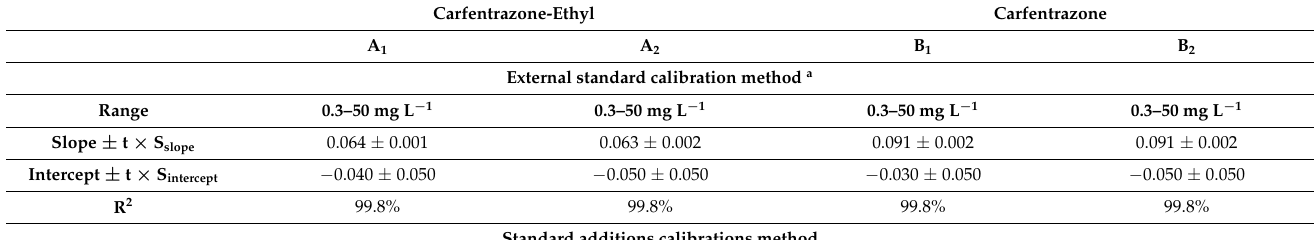
Figure 3. Electropherograms corresponding to the simultaneous separation of carfentrazone-ethyl and carfentrazone enantiomers from a standard solution containing 30 mg L −1 of carfentrazone-ethyl racemate and 20 mg L −1 of carfentrazone racemate. ( A ) Effect of the temperature; ( B ) Effect of the sodium acetate buffer concentration; ( C ) Effect of the applied voltage. Other experimental conditions as in Figure 2. A 1 and A 2 : carfentrazone-ethyl enantiomers. B 1 and B 2 : carfentrazone enantiomers. Table 1. Analytical characteristics of the CE methodology developed for the simultaneous enantiomeric separation of carfentrazone-ethyl and carfentrazone using captisol as chiral